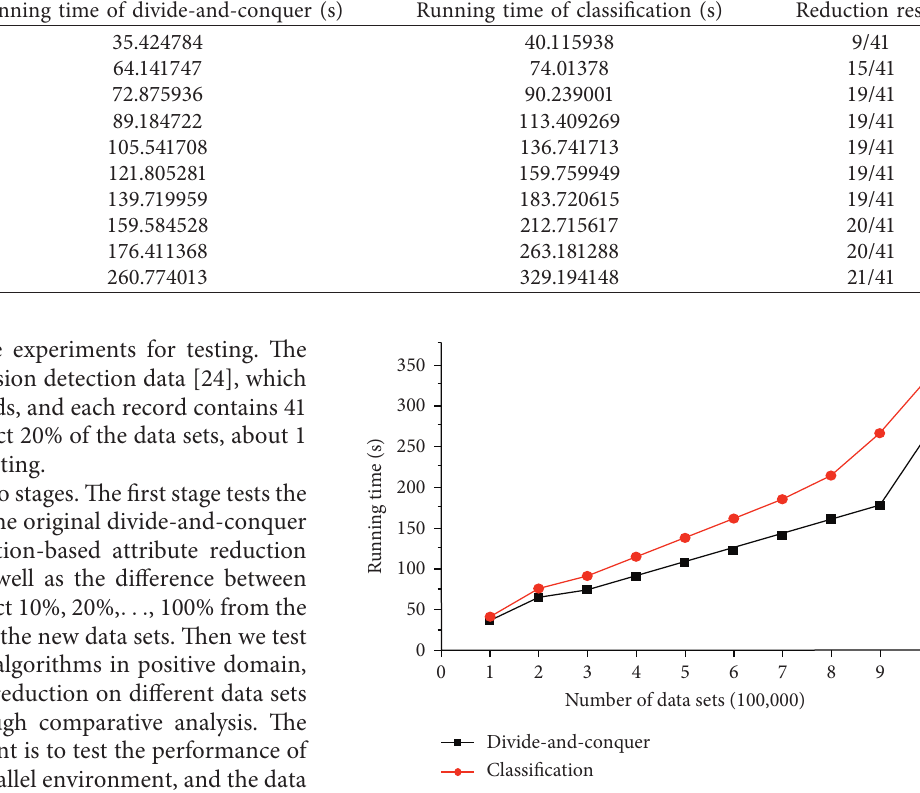
Figure 1: Running time of the two algorithms in nonparallel testing on different